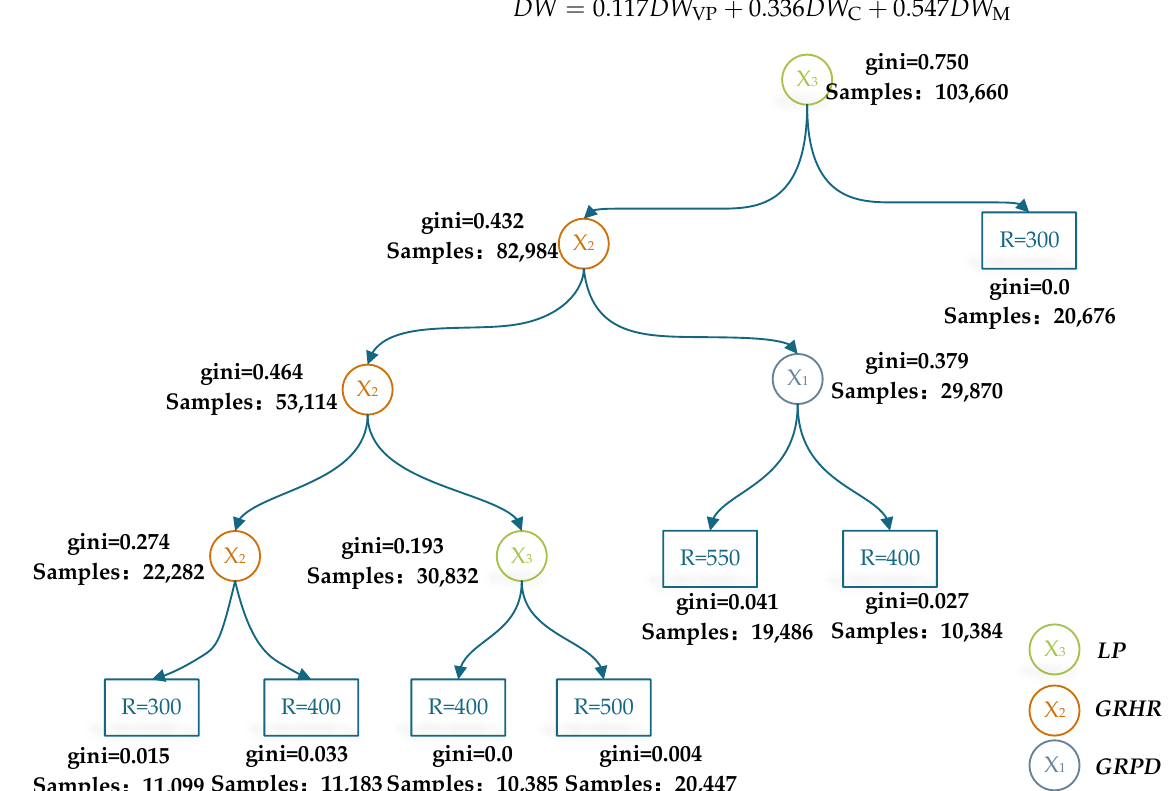
Figure 4. RTs model of multifeatures over horizontal curve sections.